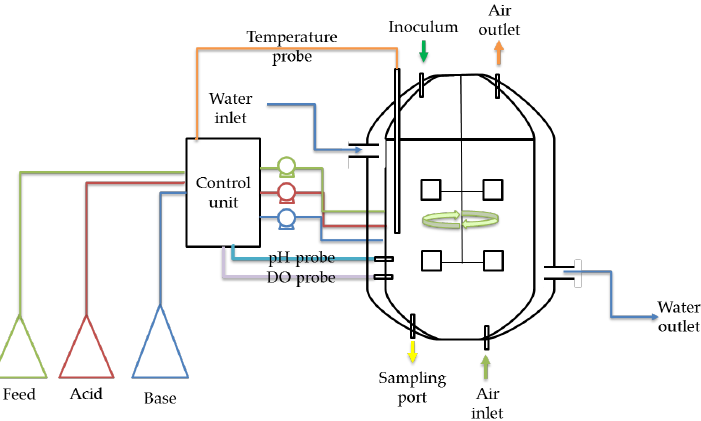
Figure 3. Schematic of submerged fermenter (stirred tank reactor) for conversion of lignocellulosic biomass to enzymes.